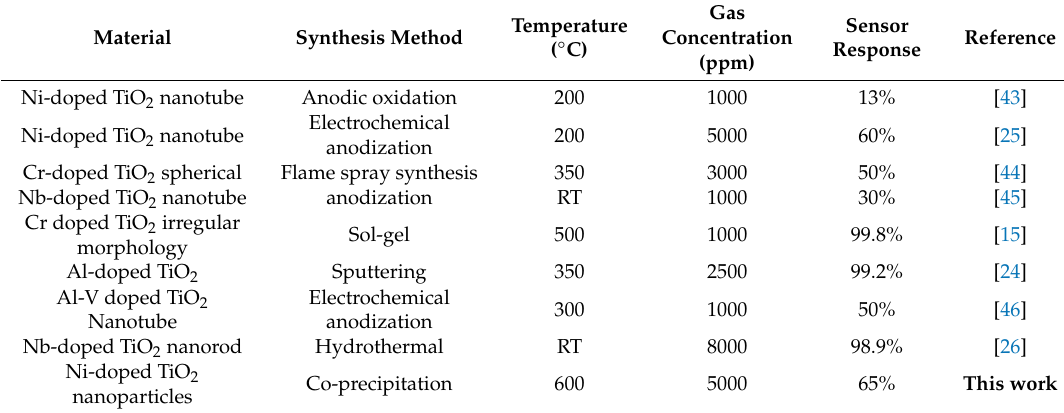
Table 3. Comparison of the optimum sensing temperature of the present sensor and that of devices previously reported in the